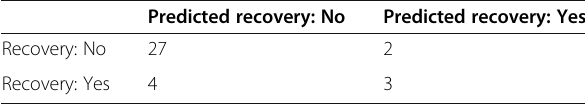
Table 2 Power of the prediction model for neurosensory recovery in post-traumatic trigeminal neuropathy after 6